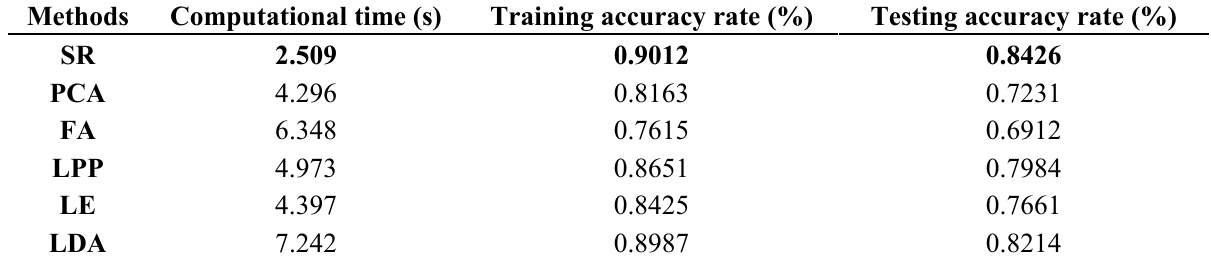
Table 5. The accuracy rate of classification by K -Means in the bearing fault data from